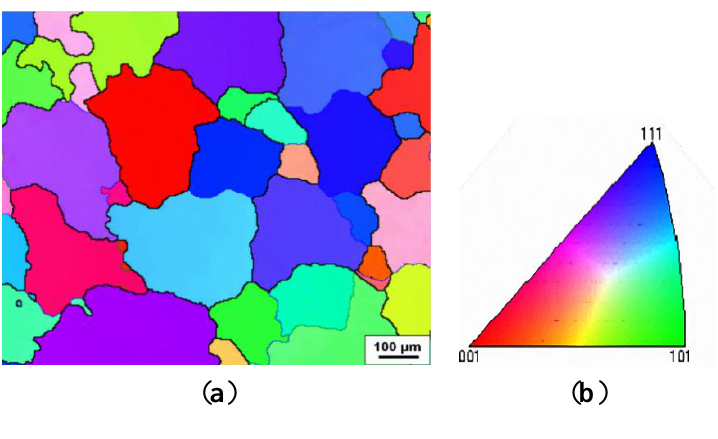
Figure 4. ( a ) Grain structure of the alloy after homogenization treatment; ( b ) representation of the color code used to identify the crystallographic orientations on a standard stereographic projection (red: [001]; blue: [111]; green: